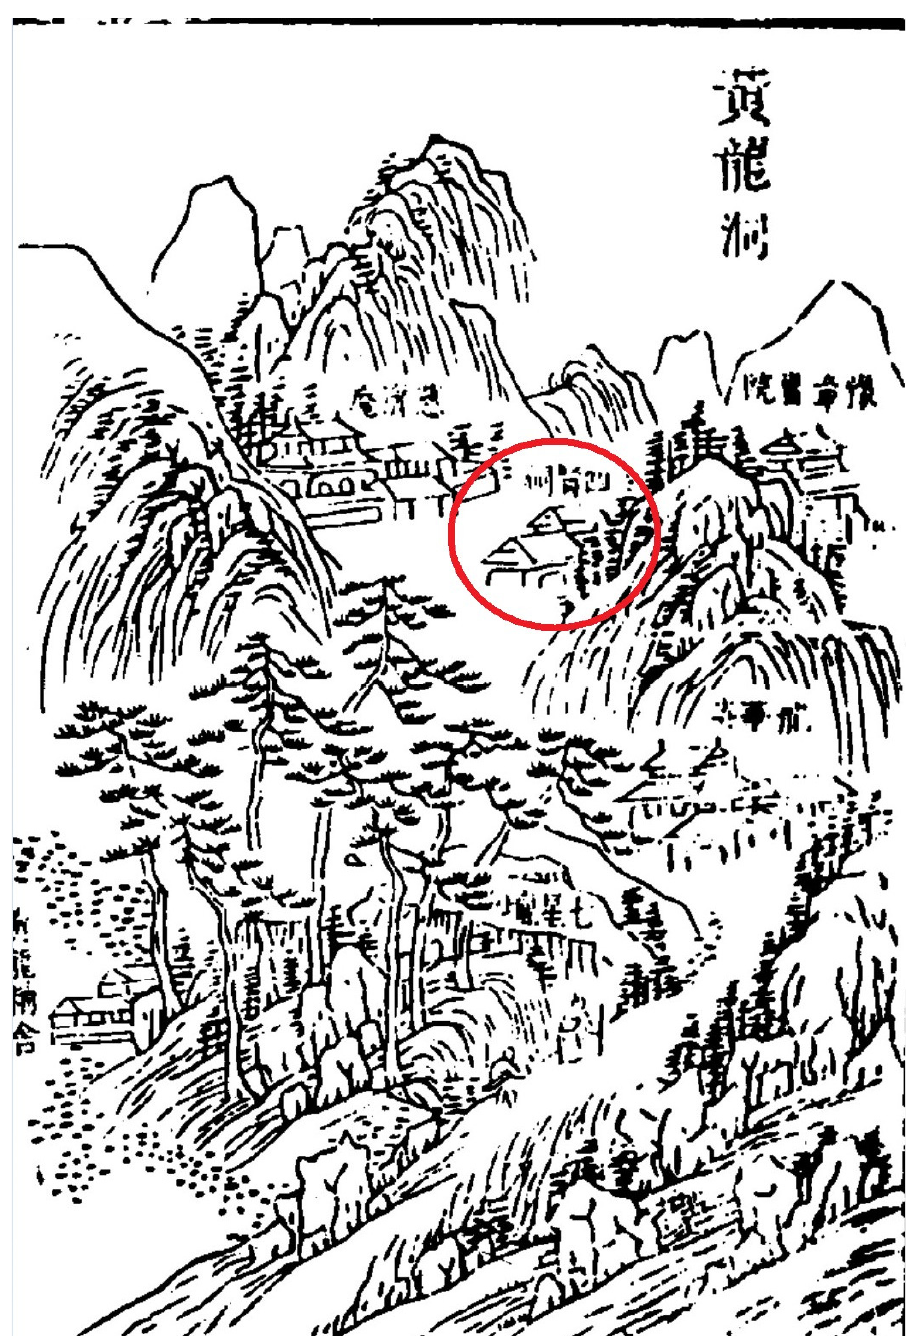
Figure 16. Image of the Sixian Ci in the Huanglong Dong image, 1639. Woodblock print. After Han Huang, Luofu yesheng , 2.41a (520). Image edited by the author.